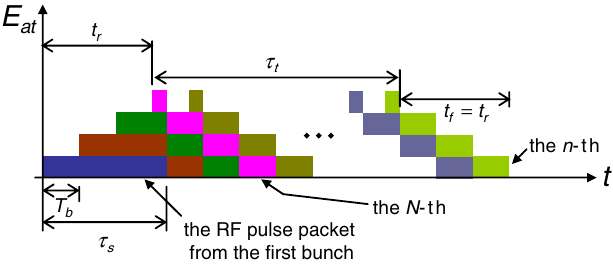
FIG. 4. (Color) The rf pulse due to a drive-bunch train. The longitudinal electrical field amplitude experienced at the exit of the decelerator with bunch train excitation (pulses excited by different bunches are labeled with different